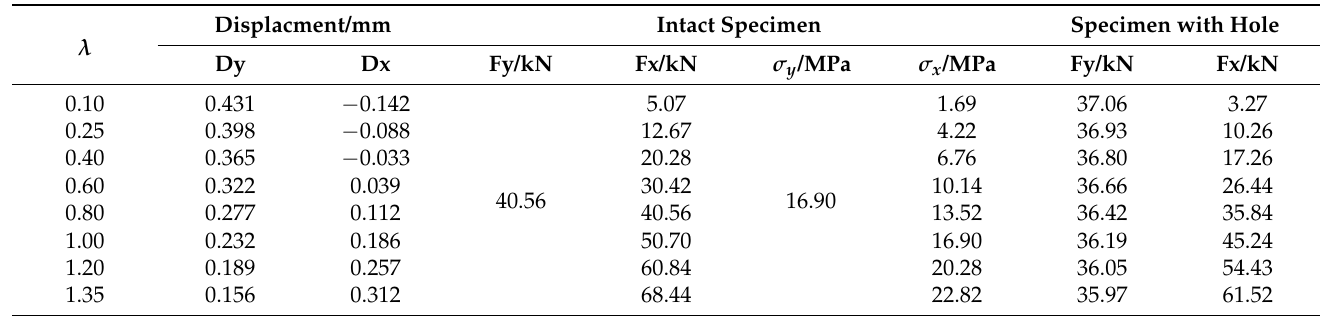
Table 7. Displacement and load in vertical and horizontal directions under different lateral pressure coefficients.